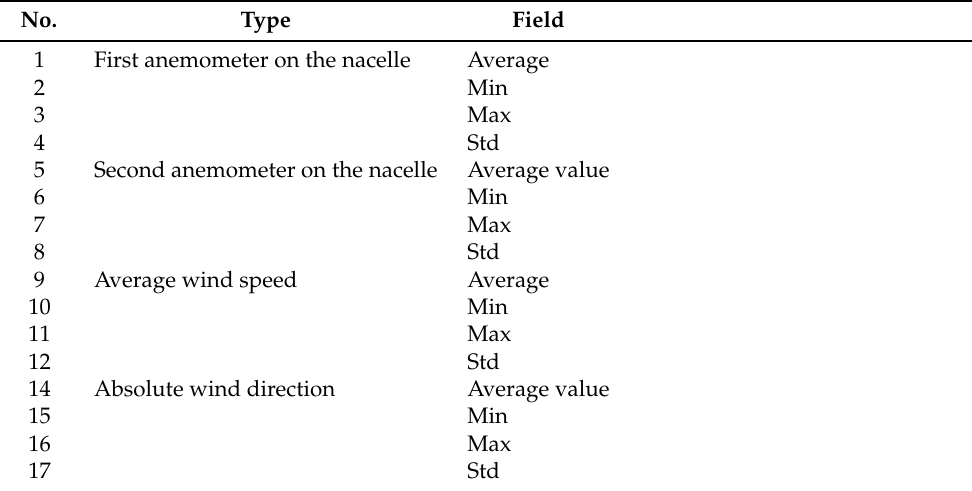
Table 1. Dataset variables: standard deviation (Std), maximum (Max), minimum (Min). No. Type Field 1 First anemometer on the